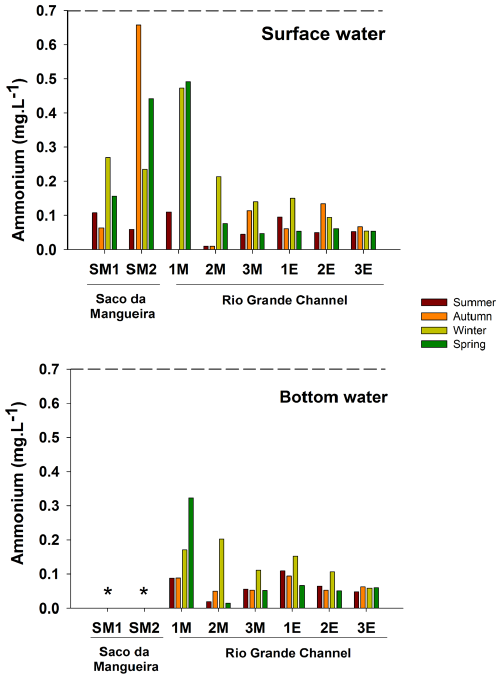
Figure 3. Seasonal variation of ammonium (mg.L -1 ) at the margin of the Saco da Mangueira (sites SM1 and SM2) and in the Rio Grande Channel, at the margin (sites 1M, 2M and 3M) and in the channel (sites 1E, 2E and 3E) in 2011. Dashed line indicates the limit established by CONAMA (2005) (0.7 mg.L -1 ). * Data are absent because of the low depth in the local.